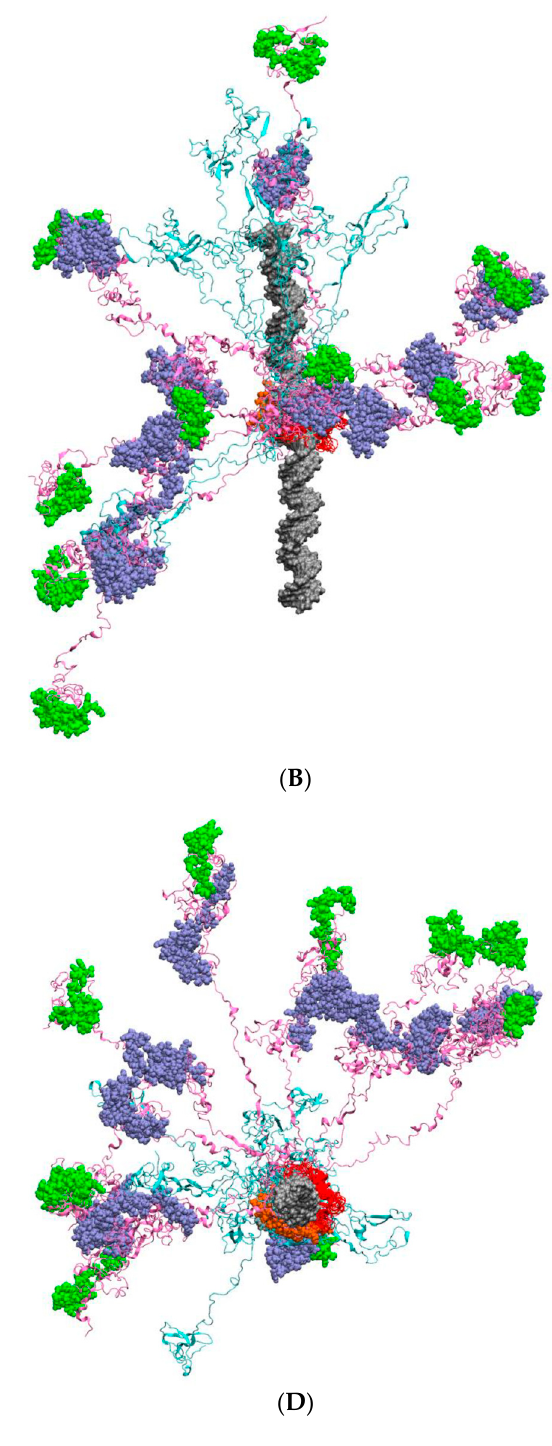
Figure 2. ( A ) Characterization of the molecular dynamics results using global variables (root mean square deviation [RMSD] and solvent accessible surface). The starting structure is located in the top left corner and the dots moving diagonally towards the lower right corner represent intermediate structures formed during the earliest stages of the simulations. All ten simulations finally generate structures that populate a dense space in the lower right corner. Each of the dots (different shades of red, blue, and purple represent different simulations) corresponds to the measurements from a single structure (‘snapshot’) sampled at 100 picosecond intervals in the trajectories (see Figure S3 for a Gaussian kernel density representation of this result). ( B ) Superimposition of snapshots representing the final structure (at 500 ns) from each of the 10 independent molecular dynamics simulations. The structures were aligned using the stably folded DNA binding motif (FOXO3 157 − 237